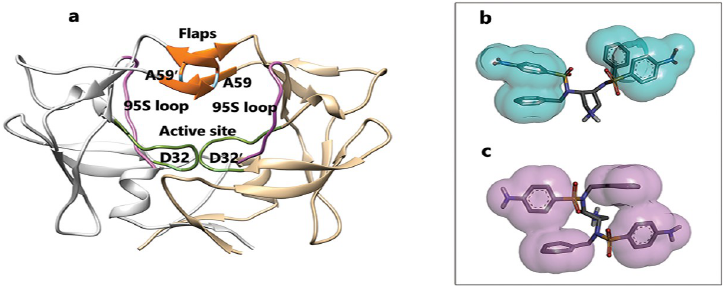
Fig 2. The 3D structure of HTLV-1 protease (PDB ID 4YDF) and intramolecular interactions of inhibitors. A , All important domains of HTLV-1 protease: the green area is the active site region, the purple area is the lateral loops or 95S loops part of protease, the orange area is the flaps region, and the blue area is the flap tips part. B , Compound 9. C , Compound 10.